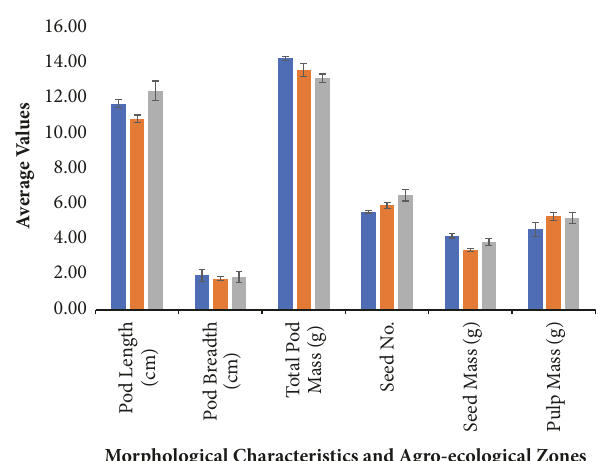
∗∗ Correlation is significant at P ≤ 0.05 level (2-tailed).